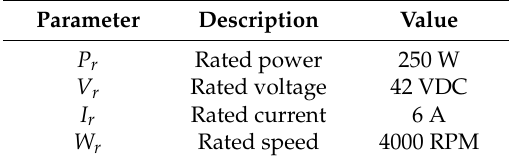
Table 1. Rated values of the DC motor.